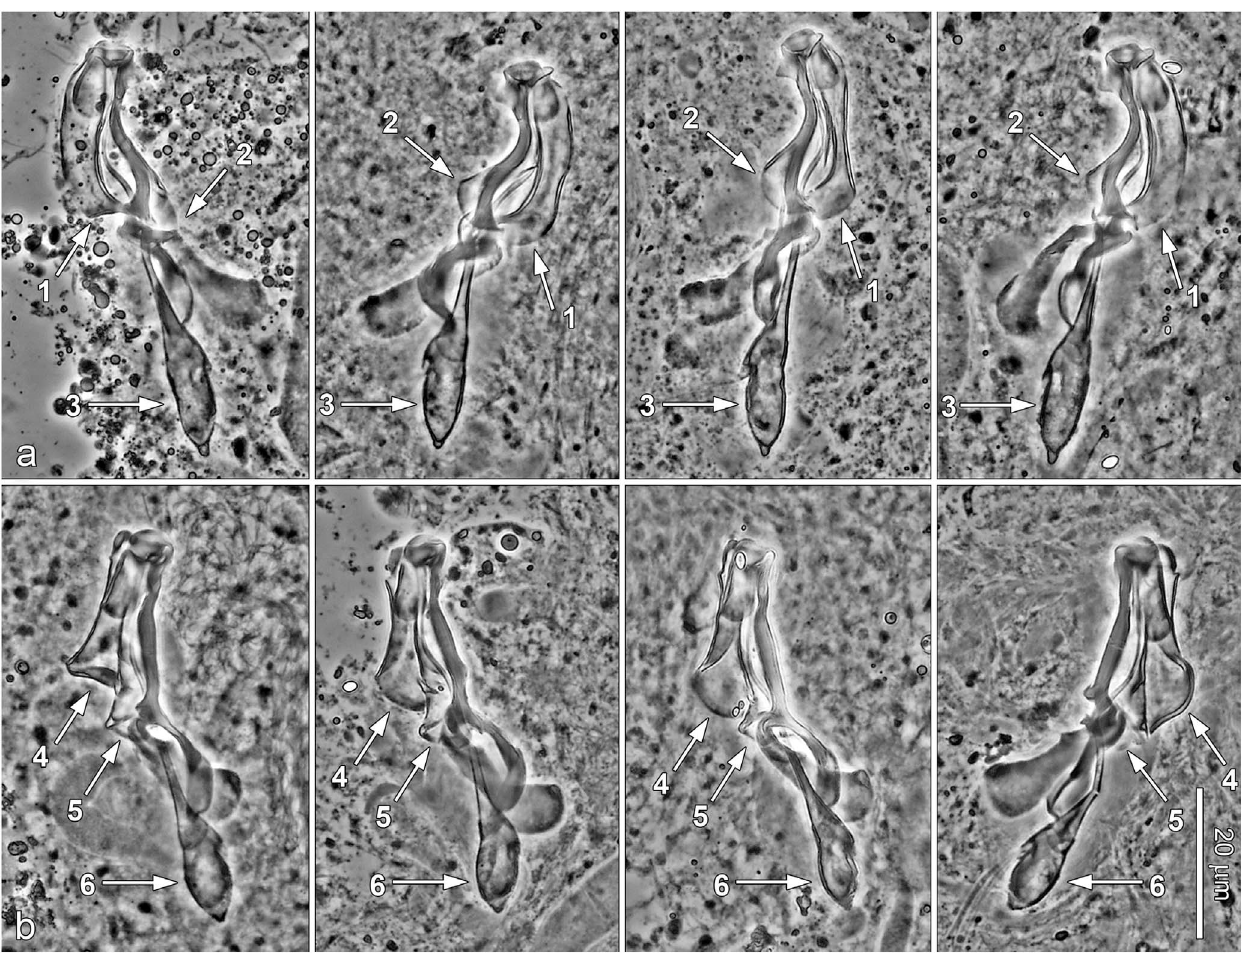
Figure 6. Phase-contrast micrographs of the MCOs in Dactylogyrus romuli n. sp. (a) and D. remi n. sp. (b). Characters of interest are indicated by arrows: (1) distal fold without expanded proximal portion, (2) medial fold on the opposite side to the distal fold, (3) base markedly elongated, (4) distal fold with expanded proximal portion (cornet shaped), (5) medial fold on the same side as the distal fold, (6) base slightly